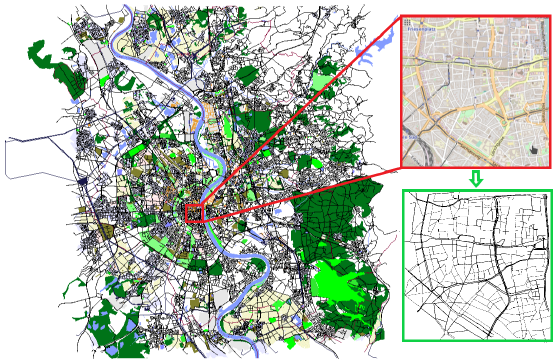
Figure 16. Topology of the Cologne